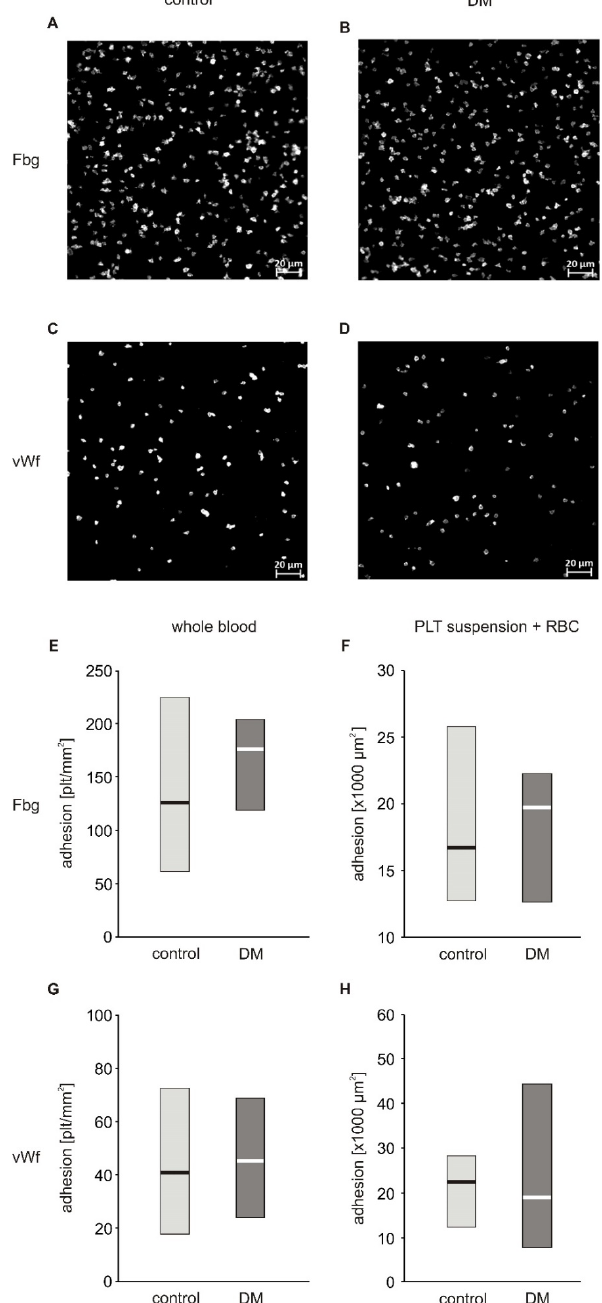
Figure 1. Adhesion of blood platelets from type 2 diabetic patients under flow conditions. Results presented as median (horizontal line) and interquartile range (box). Exemplary pictures showing adhesion of blood platelets from non-diabetic ( A , C ) and diabetic patients ( B , D ) to fibrinogen ( A , B ) and vWF ( C , D ). Adhesion of blood platelets to fibrinogen ( E , F ) and von Willebrand factor (vWF) ( G , H ) assayed in whole blood diluted with autologous platelet poor plasma ( n = 17–21) ( E , G ) and in platelet suspension in Tyrode bu ff er containing autologous erythrocytes ( n = 8) ( F , H ). Mean age 49.7 ± 7.8 (control) vs. 56.3 ± 8.8 (DM) (mean ± SD). Results are expressed as a number of platelets per surface area ( E , G ) and as area covered by platelets ( F,H ). More experimental details are given in the Materials and Methods section. Statistical significance of di ff erences between the group of diabetic patients and control subjects, estimated with the non-paired Student’s t-test, was: adhesion in whole blood: n.s., control > DM; adhesion in platelet suspension: n.s., control >